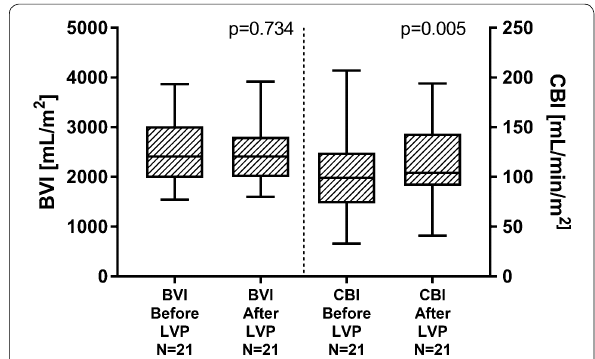
Fig. 2 Circulating blood volume index (BVI) and “ICG‑Clearance” (CBI) before and after large‑volume paracentesis (LVP), depicted as box plots (median and IQR, min to max)